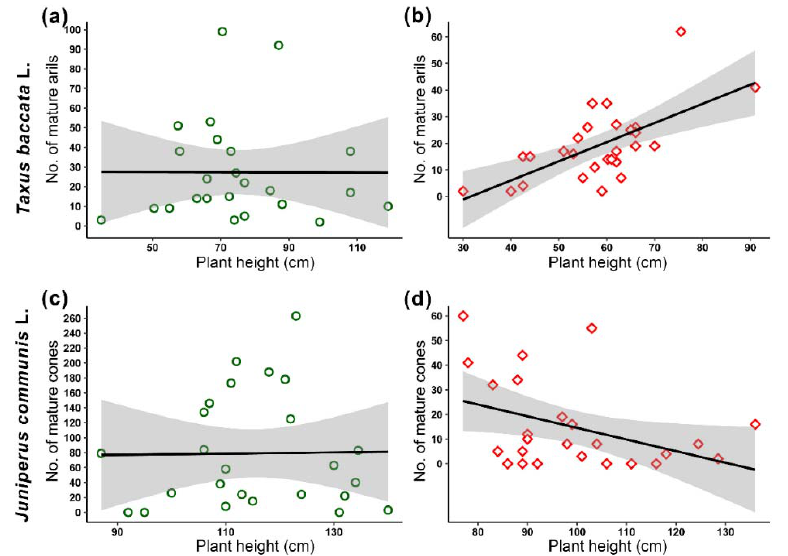
Figure 2. Number of Taxus baccata L. mature arils ( a , b ) and Juniperus communis L. mature cones ( c , d ) in relation to plant height (cm) in plants grown in fertilised (green, a , c ) and non ‐ fertilised (red, b , d ) conditions.